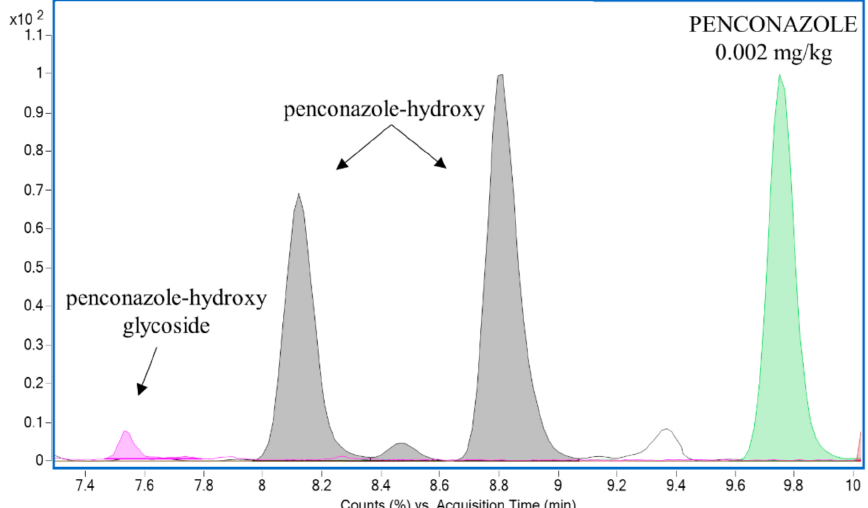
Figure 3. Overlaid extracted ion chromatograms of penconazole ( m/z 284.0721) and its metabolites penconazole-hydroxy ( m/z 300.0665, two isomers) and penconazole-hydroxy glycoside ( m/z 462.1176) in a grape sample.